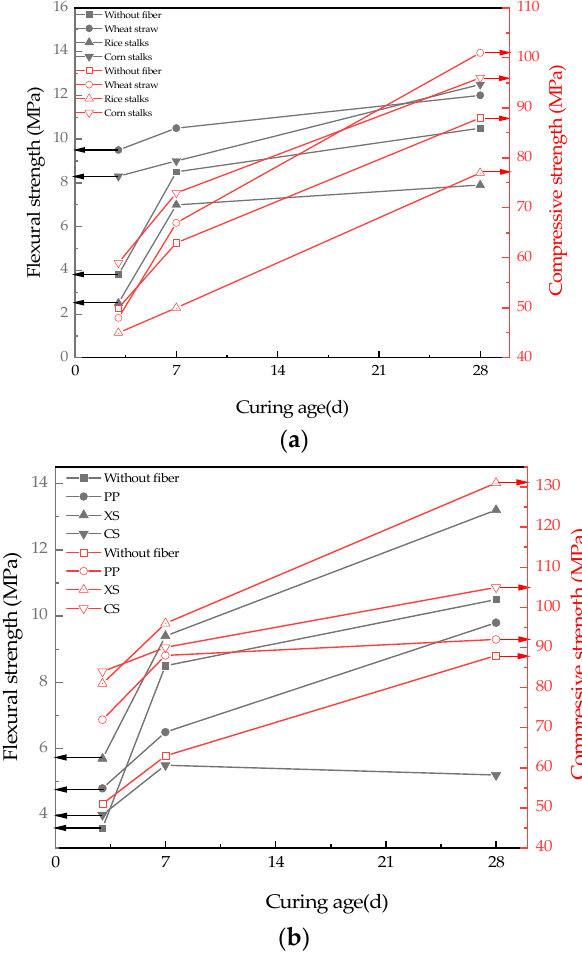
Figure 10. Mechanical strengths of alkali-activated BFS with different fibers. ( a ) Plant fibers; ( b ) Polypropylene fiber (PP), fine steel fiber (XS), and coarser steel fiber (CS).